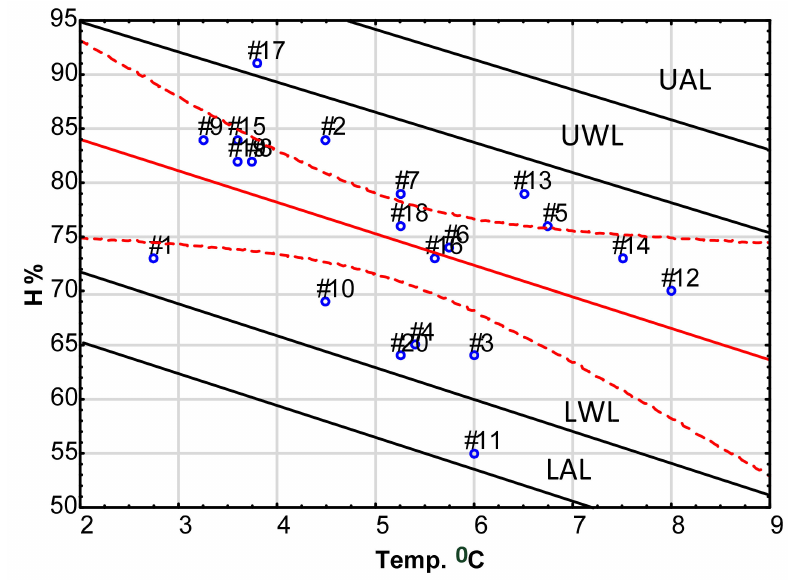
Figure 11. Regression control chart for temperature vs. humidity. Source: own data. Numbers at points # refer to sample